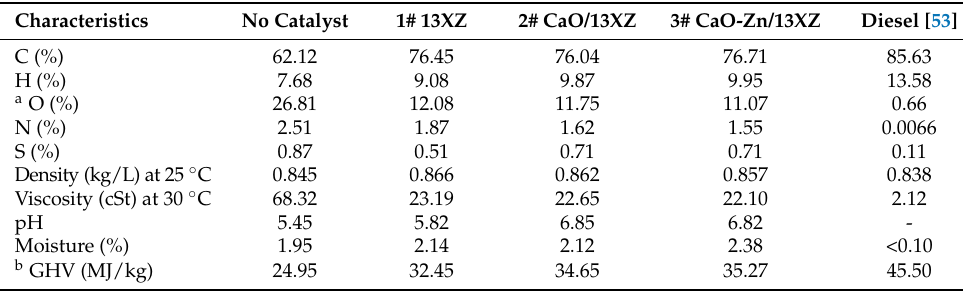
Table 4. Physical and chemical characteristics of the bio-oil obtained from pyrolysis without and with catalyst (temperature of 550 ◦ C, heating rate of 75 ◦ C/min, 0.5 mm biomass particle size and a carrier gas flow rate of 80